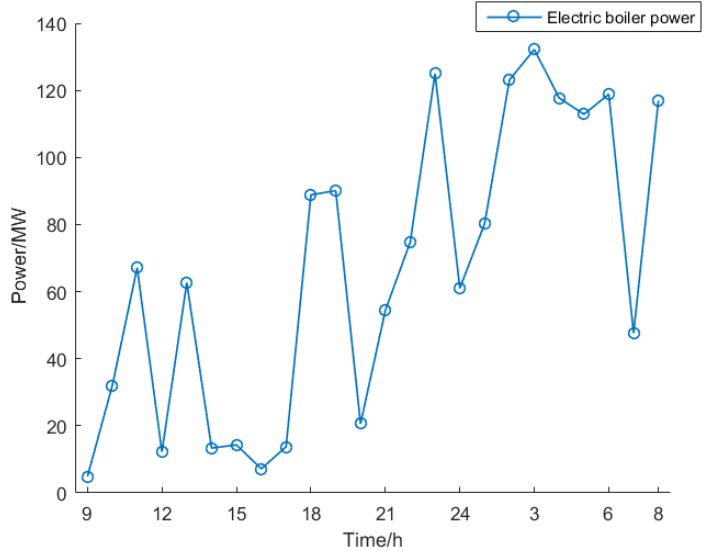
Figure 19. Electric boiler output.